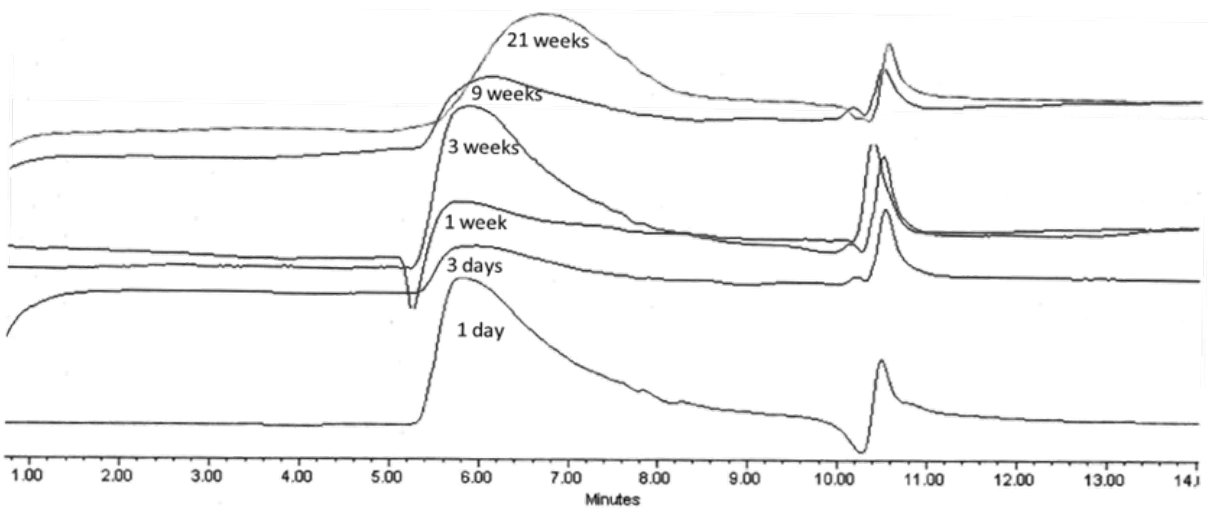
Figure 6. GPC chromatograms of PolyHOPhe-CA during the